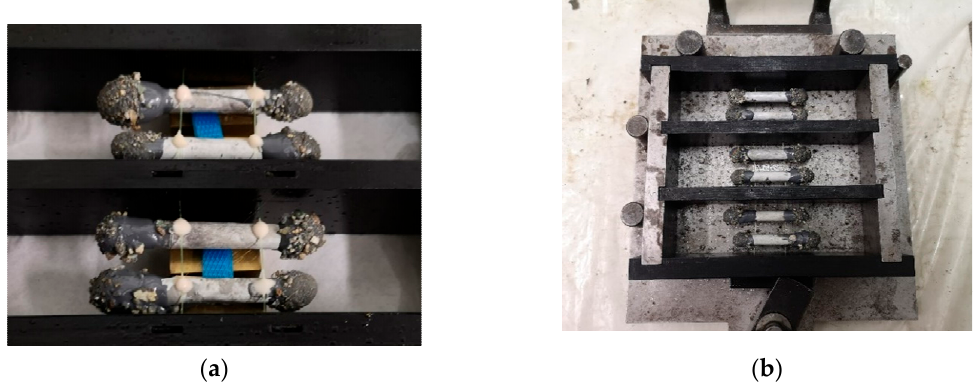
Figure 3. Mould used to produce the self-healing mortar prisms, before casting: ( a ) Bottom-up view of the capsules glued on the nylon threads with a methylmetacrylate (MMA) glue (X60, HBM, Darmstadt, Germany); ( b ) assembled and oiled mould with capsules in fixed